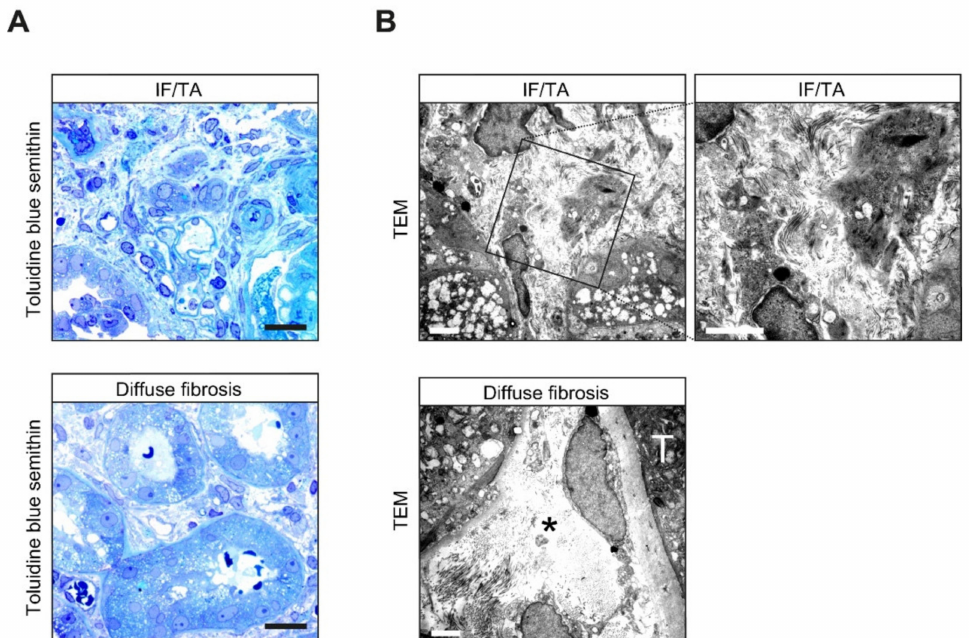
Figure 4. Ultrastructural analysis of focal IF/TA versus diffuse fibrosis reveals distinct matrix compositions. ( A ) Represen- tative photomicrograph of toluidine blue-stained semithin kidney section in ANCA GN with focal IF/TA (upper panel) and diffuse fibrosis (lower panel) are shown (scale bars: 20 µ m). ( B ) Interstitial composition analyzed by TEM revealed collagen bundles embedded in a densely packed stromal matrix in focal IF/TA. By contrast, ultrastructural analysis of diffuse fibrosis showed intact tubules (T) surrounded by a widened edematous interstitium (asterisk) with focal collagenous bundles revealed incomplete fibrotic tissue in ANCA GN (scale bars: 2000 nm). Abbreviations: IF/TA—interstitial fibrosis/tubular atrophy; TEM—transmission electron